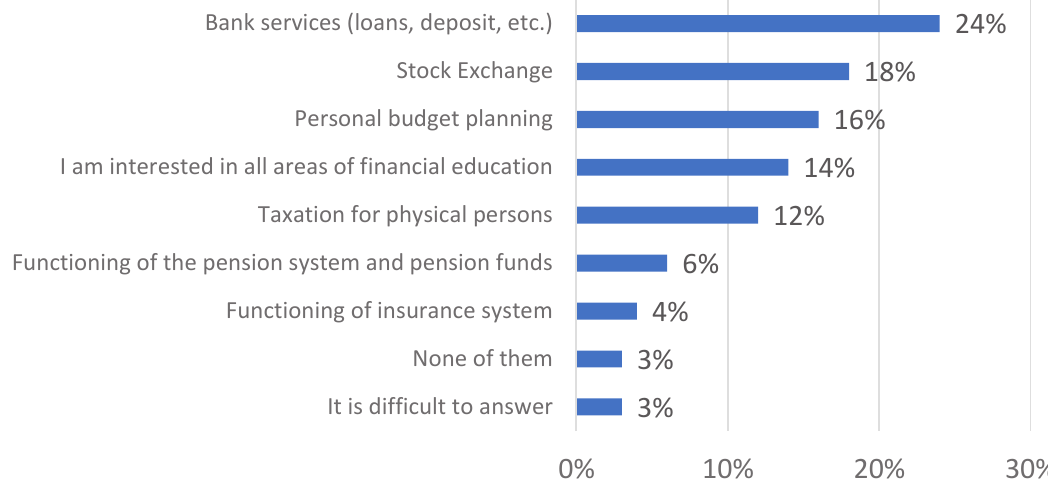
Figure 2. Grouping students according to the study of desired issues within financial